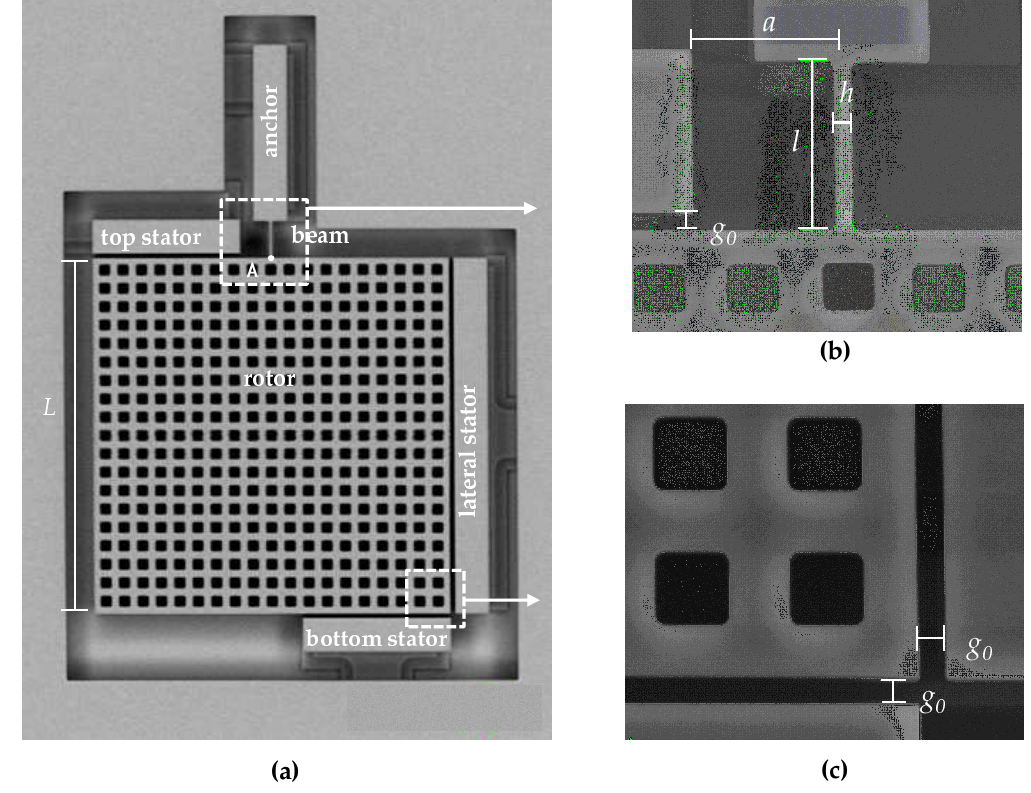
Figure 1. SEM picture of ( a ) the testing device; and close-ups of ( b ) the beam and of ( c ) the bottom-right corner of the